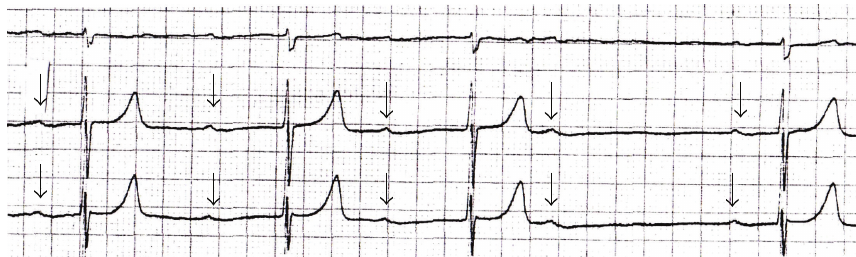
Figure 2: Rhythm strip showing progressive PR prolongation with subsequent dropped QRS complex, consistent with Wenckebach (P waves marked with arrows).